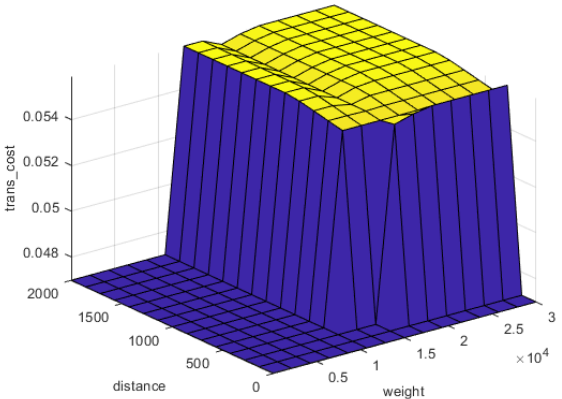
Figure 9. Transportation cost levels related to distance and weight.